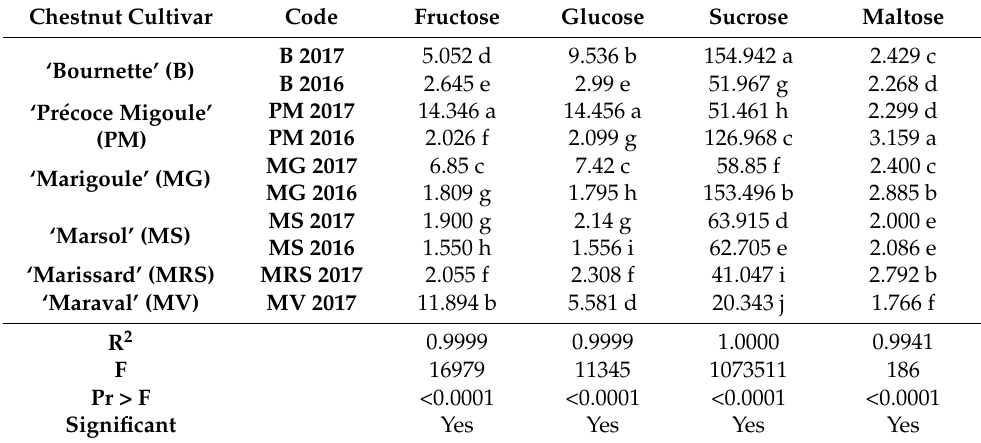
Table 5. Sugar content in different chestnut cultivars harvested in 2016 and 2017 (g/kg DW). Chestnut Cultivar Code